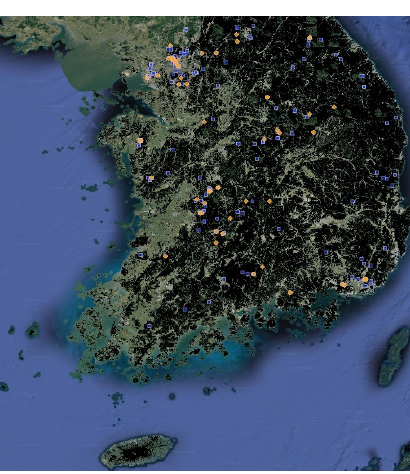
Figure 5. Observations of Rana huanrenensis in South Korea.